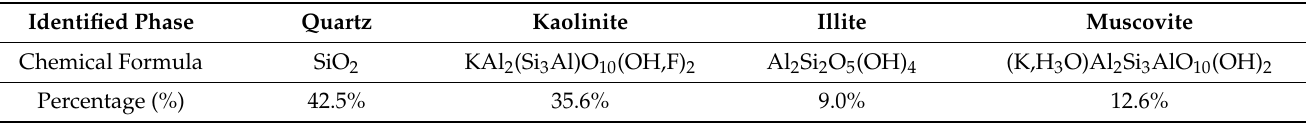
Table 1. Percentage of the minerals in the